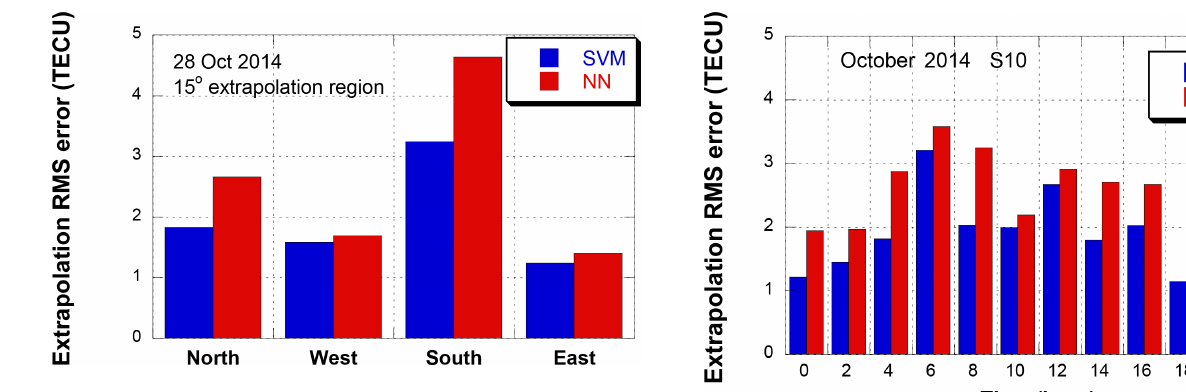
Figure 11. Extrapolation errors for each direction (15 ◦ extrapola- tion regions).